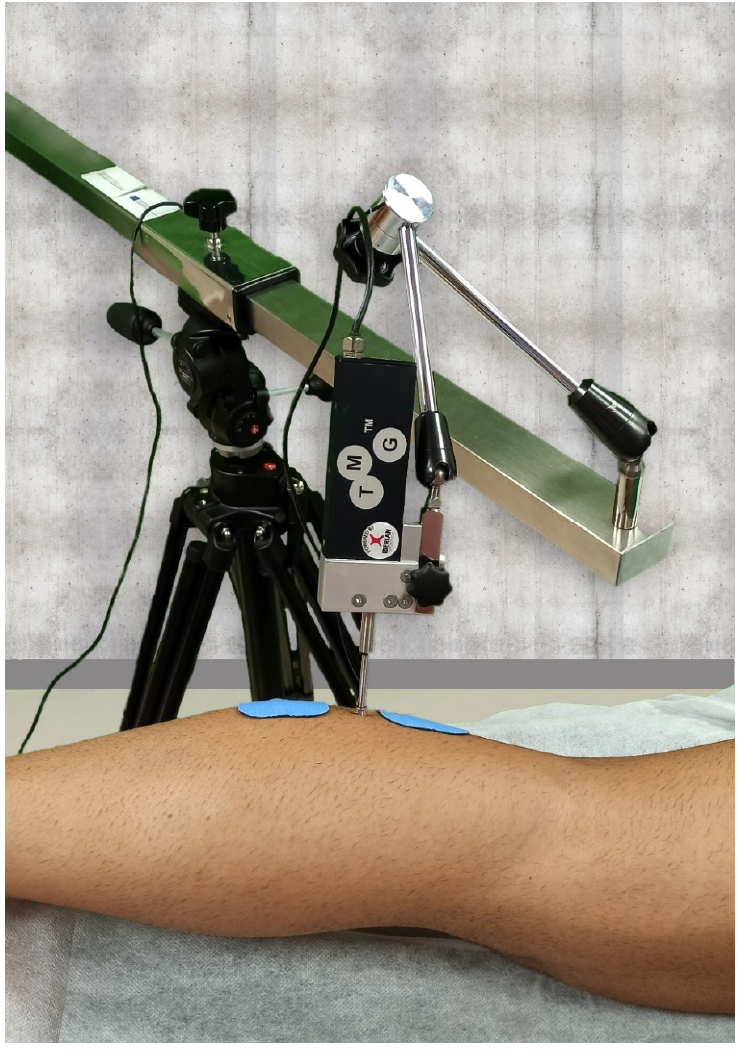
Figure 2. Contractile properties of gastrocnemius muscles were assessed by tensiomyography.